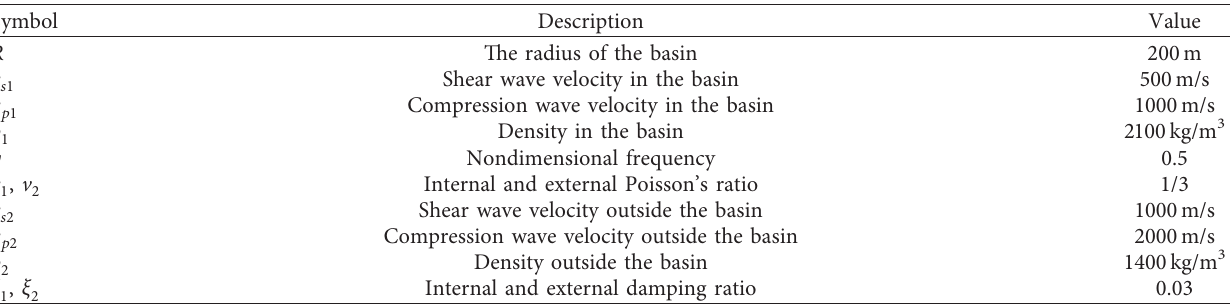
Figure 4: The error analysis diagram of the x -direction displacement amplitude and the theoretical value of the free field surface node: (a) the x -axis; (b) the y -axis. Table 2: List of some important notations and